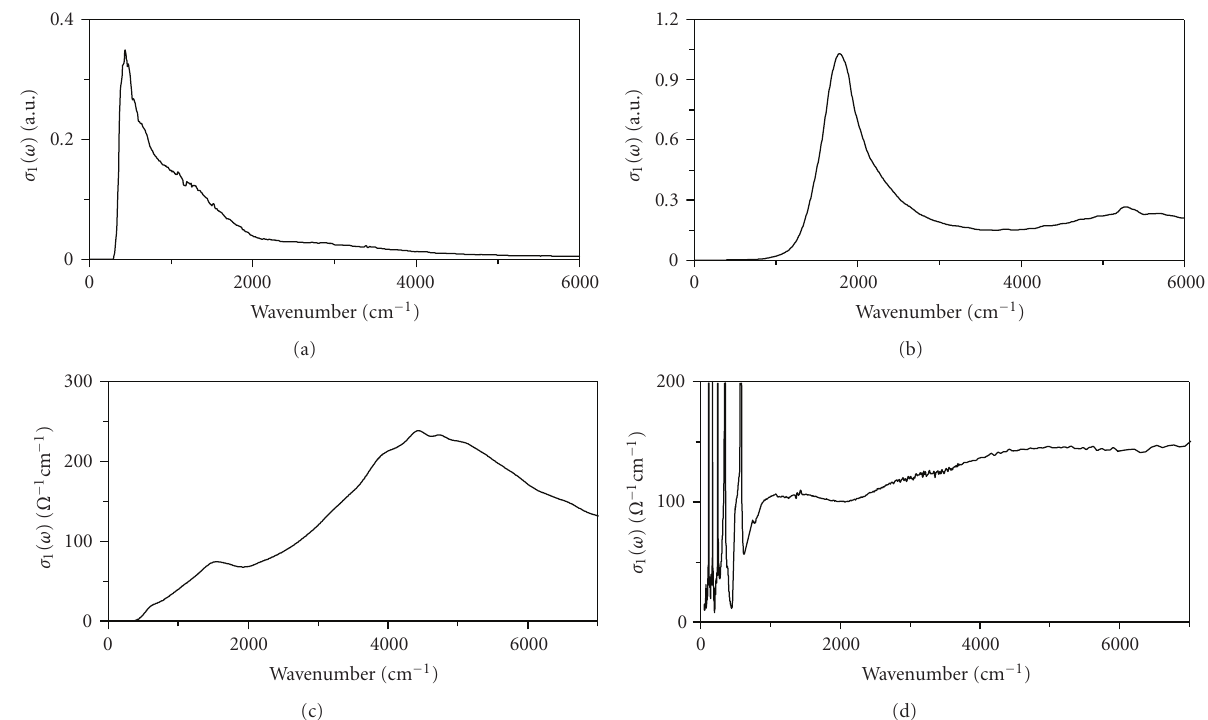
Figure 9: Typical OC of di ff erent models in two-dimensions and experimental data in weakly doped system: (a) Holstein model at λ = 0 . 44; (b) t-J model at J = 0 . 3; (c) t-J-H at J = 0 . 3 and λ = 0 . 39; (d) in-plane OC of doped by x = 1 . 5% holes Eu 1 − x Ca x Ba 2 Cu 3 O 6 at T = 10K. Theoretical energy scale assumes t = 0 . 3eV (1eV = 8065.5 cm − 1 ). The absolute values of the theoretical σ 1 estimated assuming that hopping distance in plane is a = 3 . 86 ˚A and the bulk concentration of holes is n h = 1 . 72 × 10 − 23 cm − 3 .